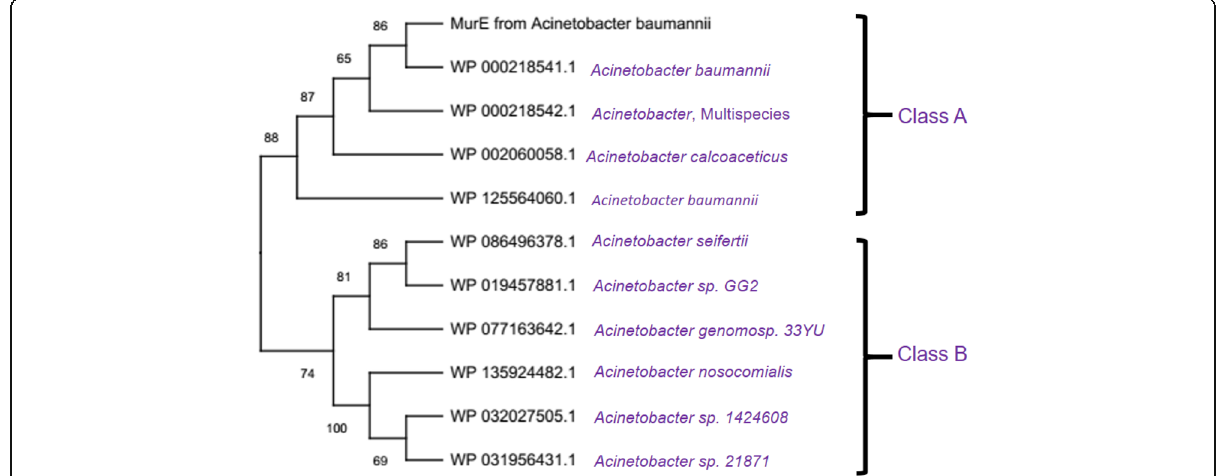
Fig. 8 Phylogenetic tree construction of MurE from A . baumannii with related protein sequences using NJ method. For the clarity, part of the tree was presented